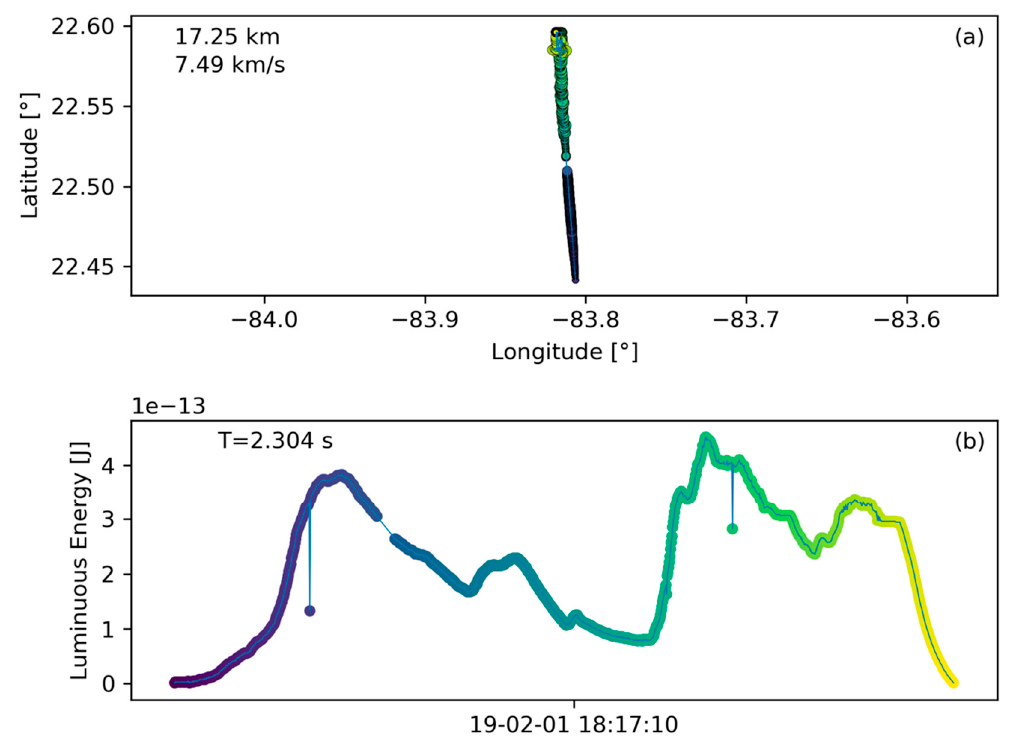
Figure 15. ( a ) Ground track and ( b ) light curve information of the Cuba meteor on 1 February 2019.